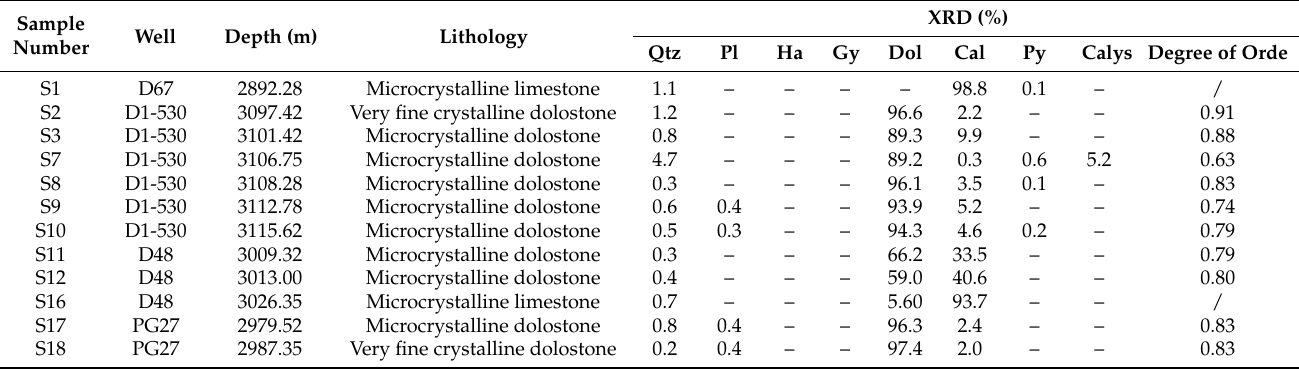
Table 2. XRD data of the M 55 from the Daniudi Gas Field in the Ordos